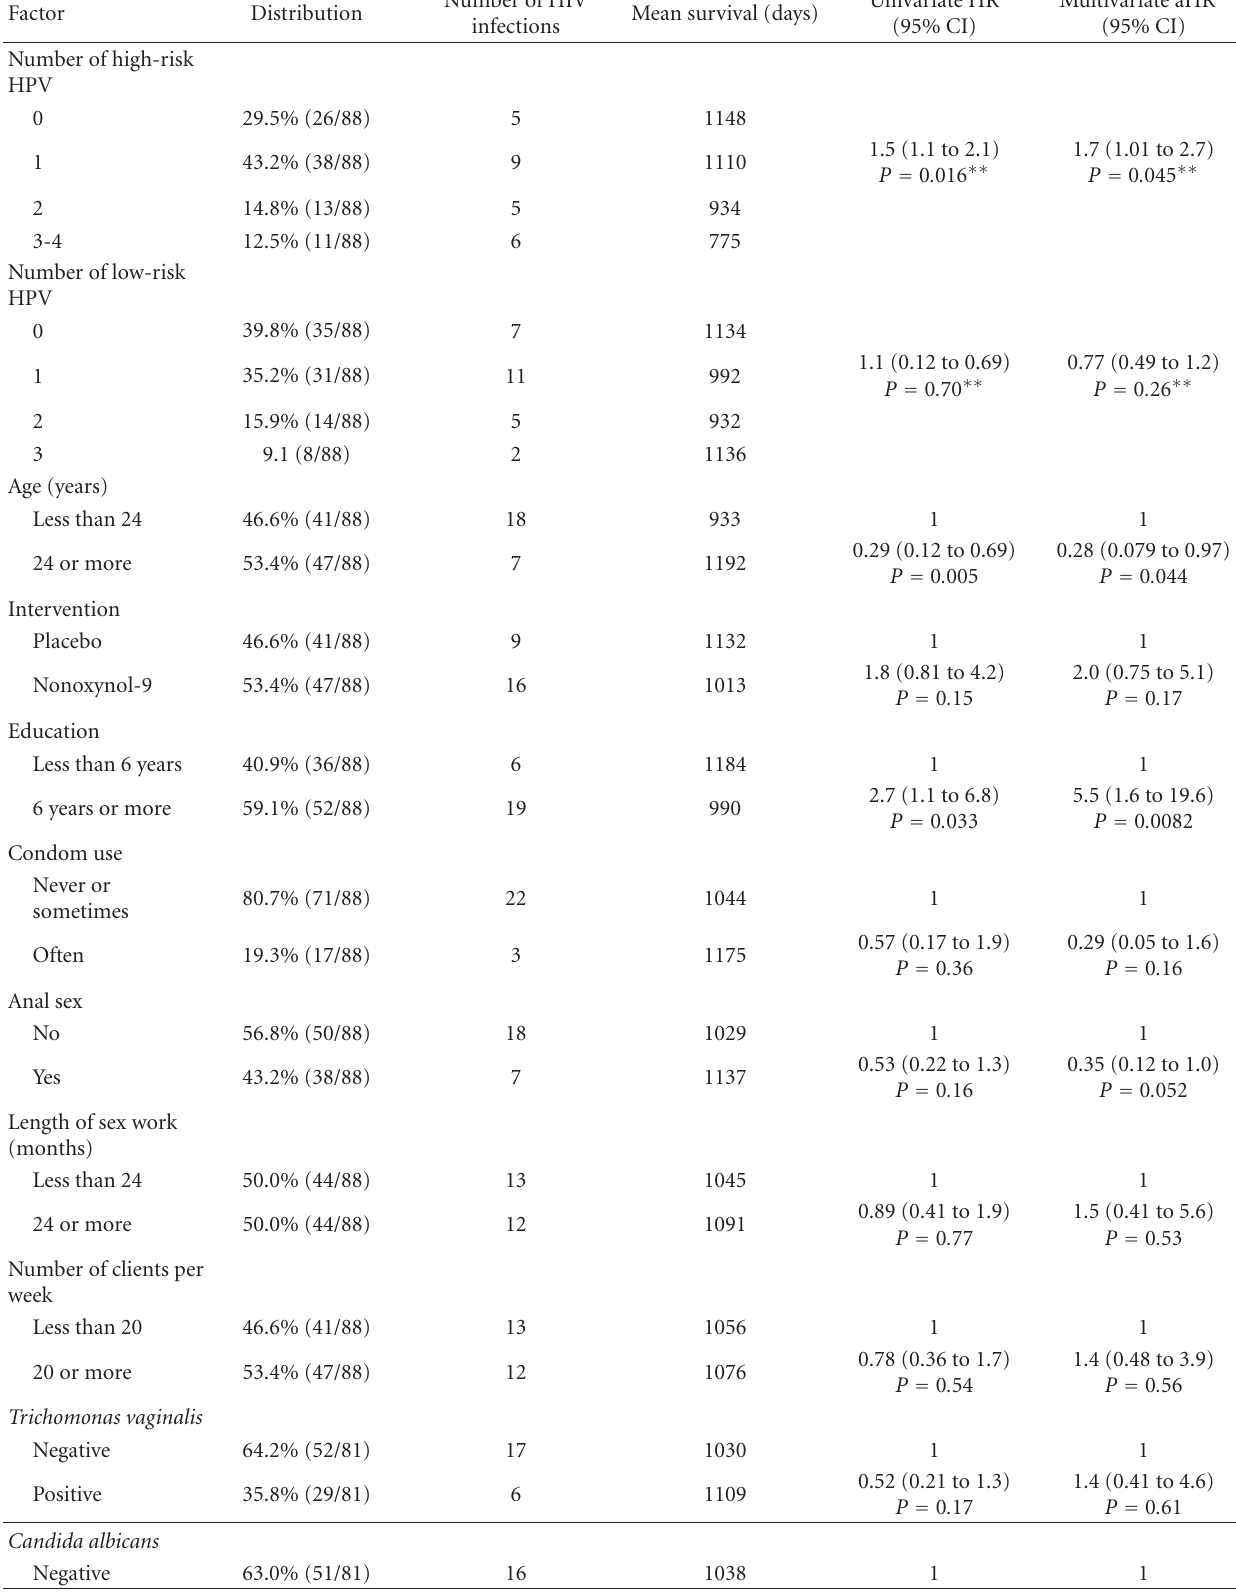
Table 1: Distribution of detected HIV cases and risk factors of HIV